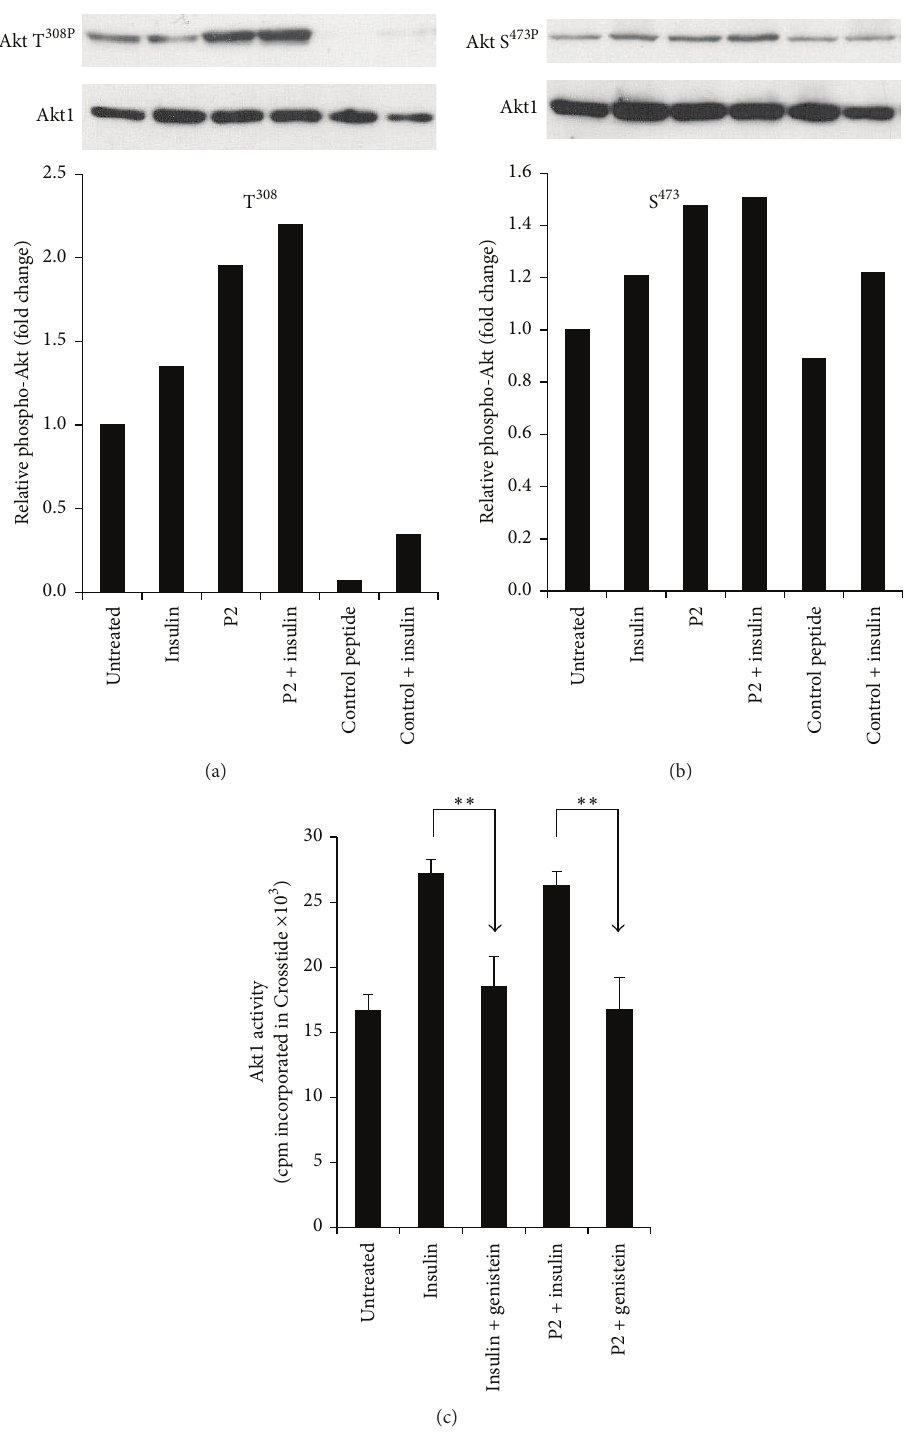
Figure5:P2activatesAkt.(a)P2stimulatesphosphorylationofAktT 308 incells.HEKcellswereserum-starvedovernightandtreatedwiththe indicated myristoylated peptides (40 𝜇 M) for 15 min; insulin (100 nM) was added for the final 10 min of treatment. Cell lysates were analyzed by Western blot; the blot was probed with antibody to phospho-Akt T 308 , followed by anti-Akt1 to control for loading. Signals were quantified by densitometry, and the phospho-Akt: total Akt1 ratio is expressed relative to that of untreated cells (control peptide; KKEVGKD). (b) P2 stimulates phosphorylation of Akt S 473 in cells. A Western blot of identical lysates to those in (a) was probed with antibody to phospho-Akt S 473 , followed by anti-Akt1. Quantification is as in (a). (c) P2-mediated activation of IRK resulted in stimulation of Akt kinase activity in cells . Cells were serum-starved overnight and treated with myristoylated peptides and insulin as in (a). Genistein (50 𝜇 M) was added to cells 30 min prior to treatment with peptide or insulin. Akt1 was immunoprecipitated from the lysates and kinase activity was measured using Crosstide as substrate ∗∗ 𝑃 < 0.01